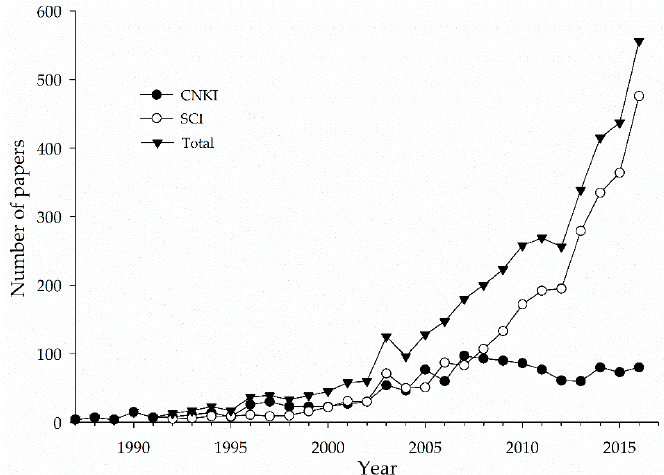
Figure 1. Annual quantity of literatures on soil and water conservation from 1987 to 2016.